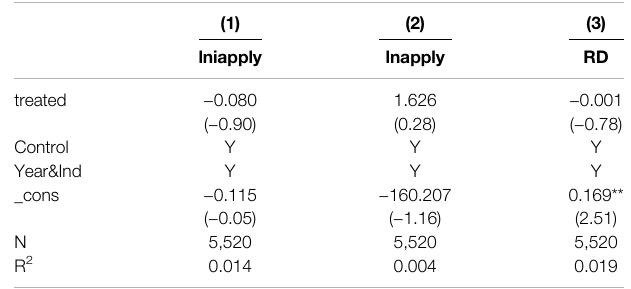
TABLE 6 | Impact of the new Environmental Protection Law on enterprise